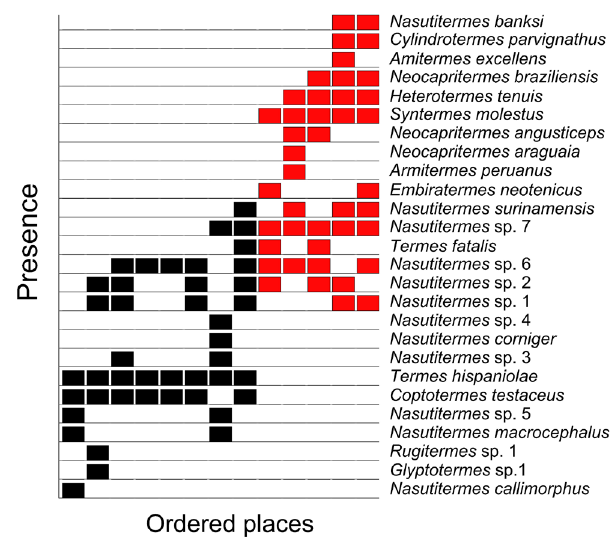
Species distribution in the ghost and terra firme forests. The red and black squares represent the presence of a species in a ghost or terra firme forest transect respectively. The transects were ordered using the Jaccard similarity index in the PCoA analysis without previous separation of ghost and terra firme